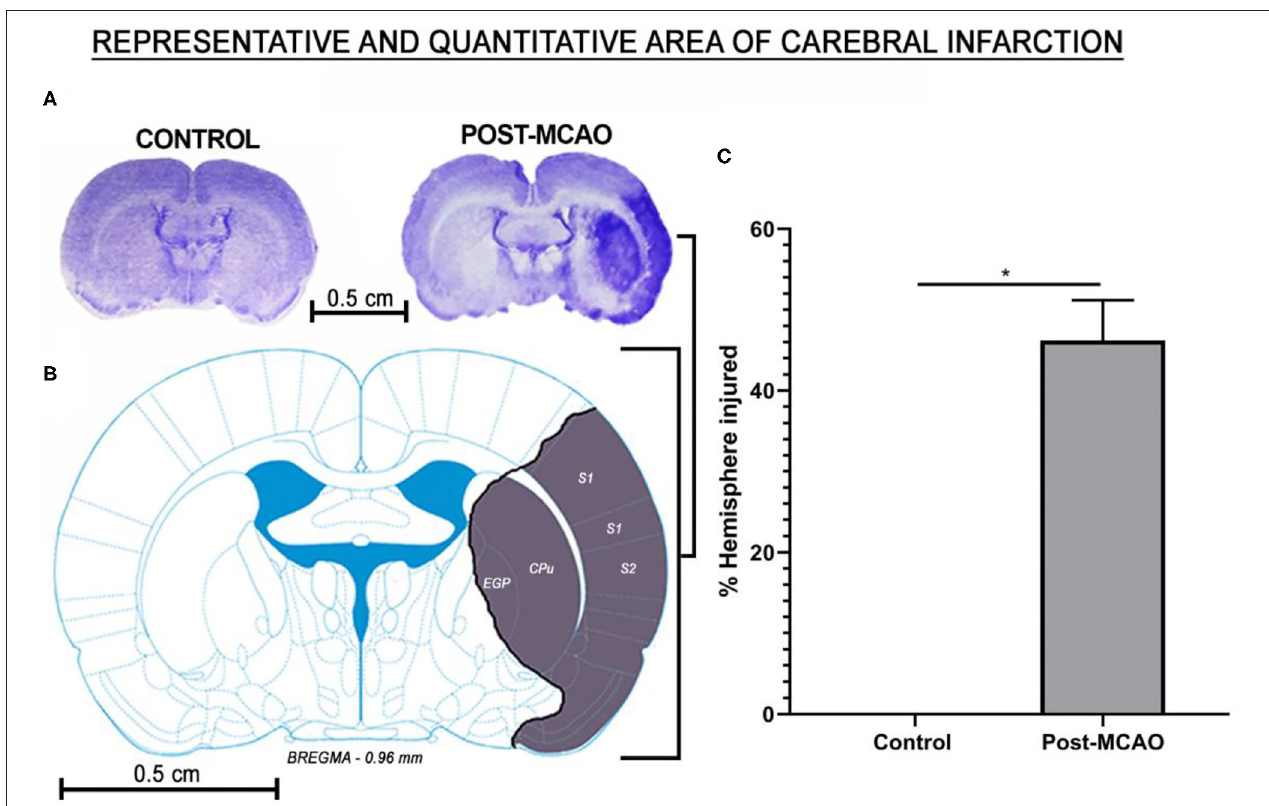
FIGURE 5 | Affected area and the percentage of cerebral infarction area. (A) Representative image of the injured hemisphere in which the electrodes were implanted: control (left) and post-MCAO (right). (B) Schematic representation of the injured regions. (C) Mean percentage of injured cerebral hemisphere. The data are expressed as means ± SD ( n = 6 animals per group); * p < 0.05: control vs. post-MCAO group. S1, primary somatosensory area; S2, secondary somatosensory area; EGP, external globus pallidus; CPu, caudate